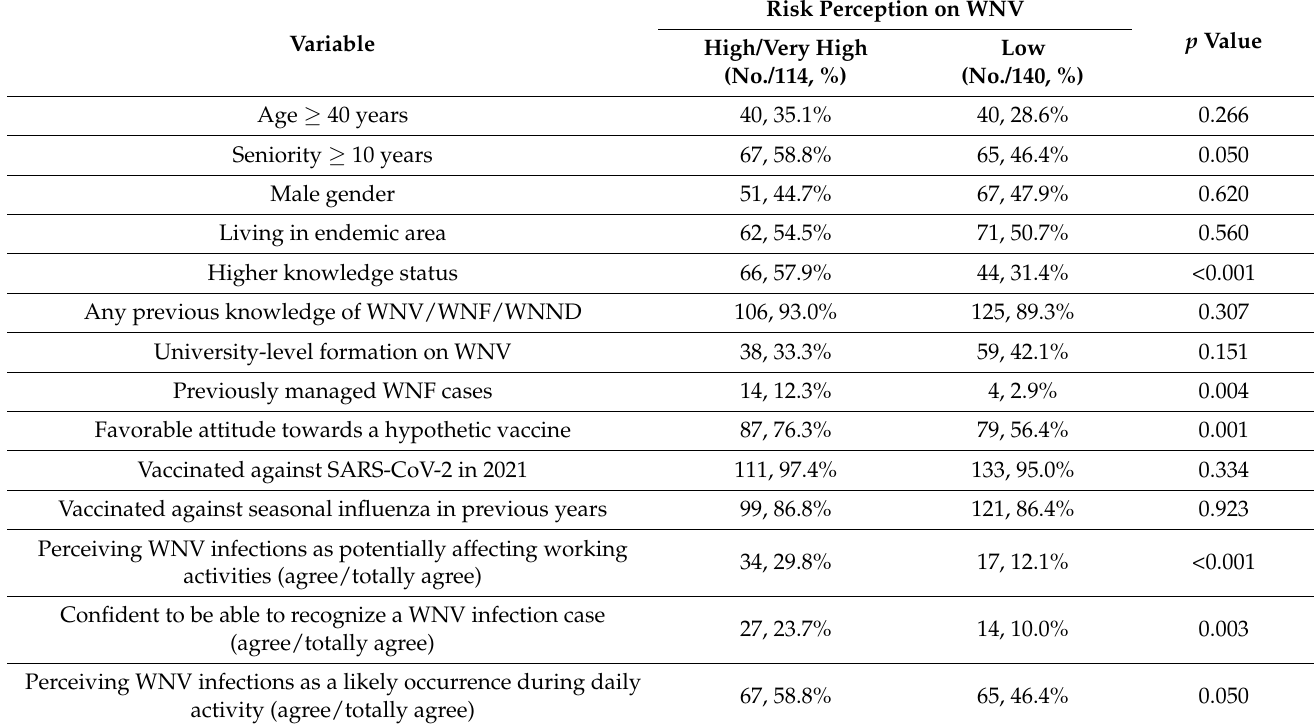
Table 2. Characteristics of the 254 Italian medical professionals participating into the survey on knowledge, attitudes, and practices on West Nile virus (WNV) by having or not having higher risk perception on WNV infections.